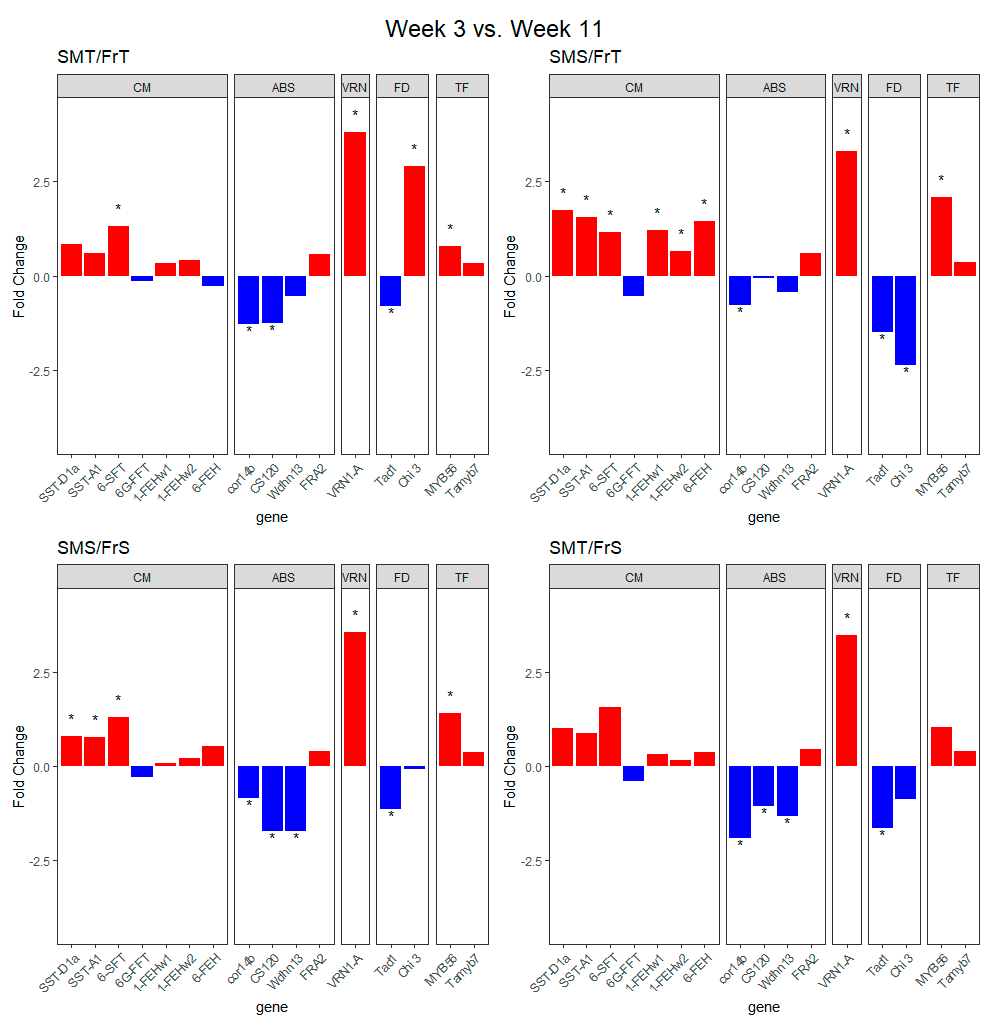
Figure 3. Fold change transcript expression between dates within RILs of different categories of freezing and snow mold tolerance. Genes were grouped and labeled by the hypothetical function categories; carbohydrate modification, drought/cold stress, vernalization, fungal defense, and transcription factor represented by the abbreviations CM, ABS, VRN, FD, and TF, respectively. “*” denotes genes with significant differences (q < 0.05) in transcript expression between week 3 and week 11 of the study.